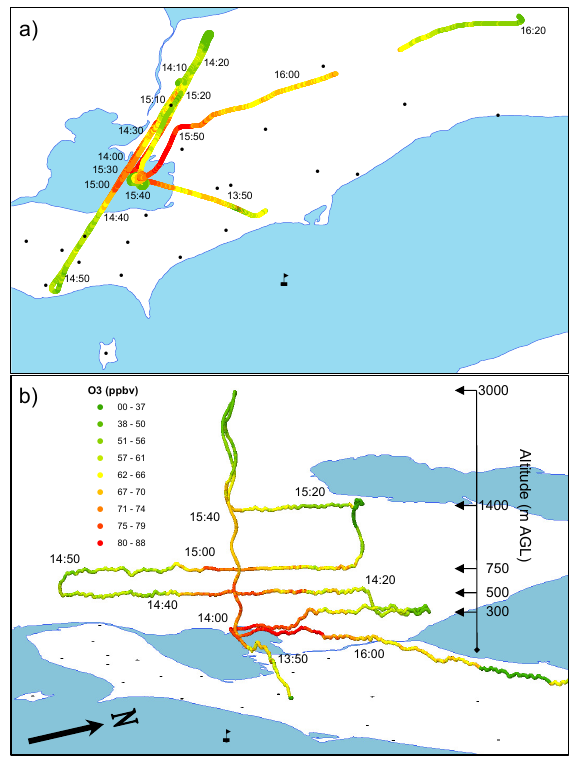
Fig. 10. (a) Plan view and (b) side view from southeast of the air- craft flight on 7 July 2007 between 13:40 and 16:20EDT, with col- ors indicating ozone mixing ratios (ppbv). Times are related to the time series shown in Fig.